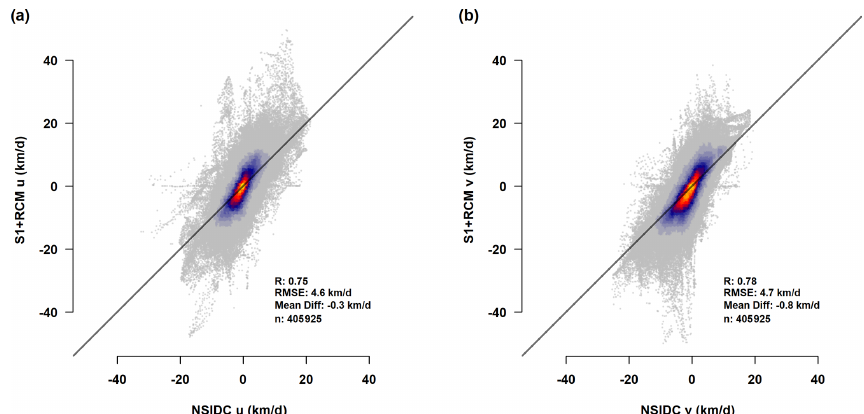
Figure 17. Heat scatterplots of S1 + RCM sea ice motion versus National Snow and Ice Data Center (NSIDC) SIM for (a) u and (b) v vector components. Also shown is the number of samples ( n ), Pearson’s correlation coefficient ( R ), root-mean-square error (RMSE), and the mean difference (MD).